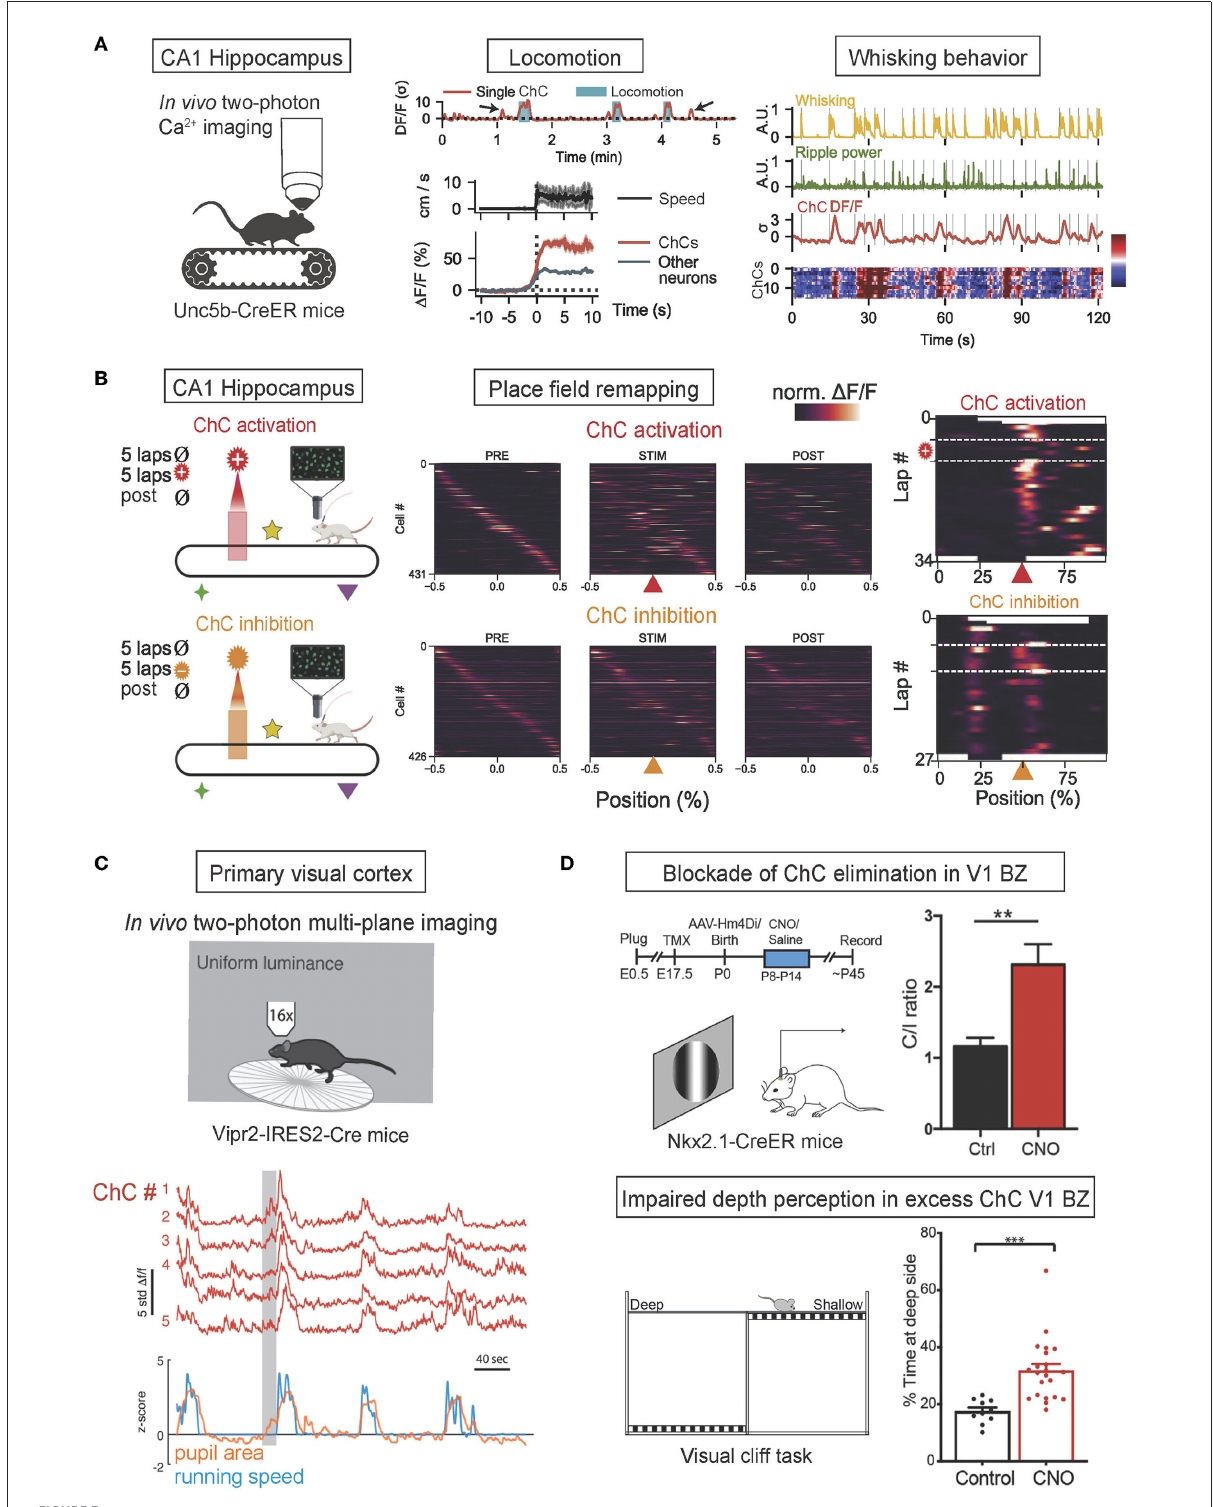
FIGURE3 In vivo functions of ChCs during behavior. (A) In vivo two-photon calcium imaging of ChC activity in ChC-specific Unc5b-CreER mice on a treadmill. The increase of ChC activity in the CA1 hippocampus is associated with the onset of locomotion and whisking behavior.